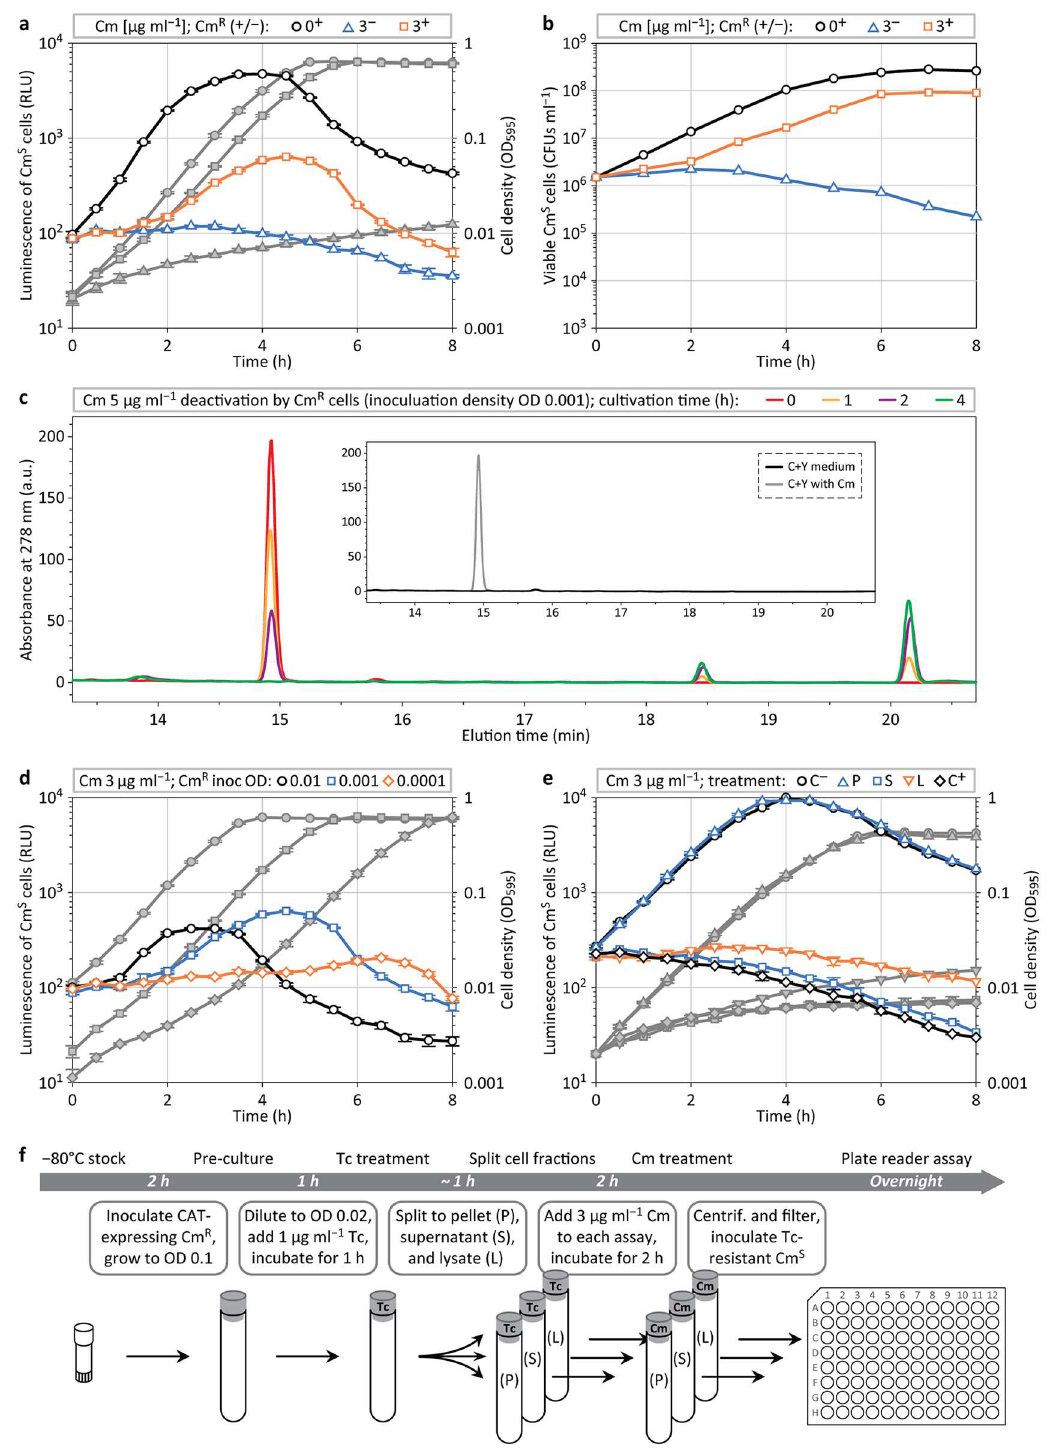
Fig 2. Cm deactivation during mixed population assays. ( a ) Plate reader assay sets in quadruplicate(average and standard error of the mean [s.e.m.]) measuring luminescence (symbols with color outline)and cell density (corresponding grey symbols) of S . pneumoniae Cm S growingin the presence of 3 μ g ml − 1 Cm, in presence(+) or absence( − ) of Cm R cells. ( b ) Development of the count of viableCm S cells (colony-forming units per ml [CFUs ml − 1 ]) duringthe cultivationassay presentedin a , determinedvia platingin the presenceof kanamycin; averagevalues